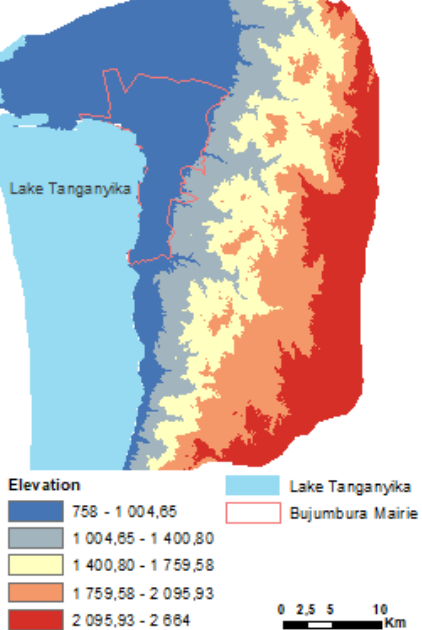
Figure 4. Elevation classes and location of Bujumbura city in the